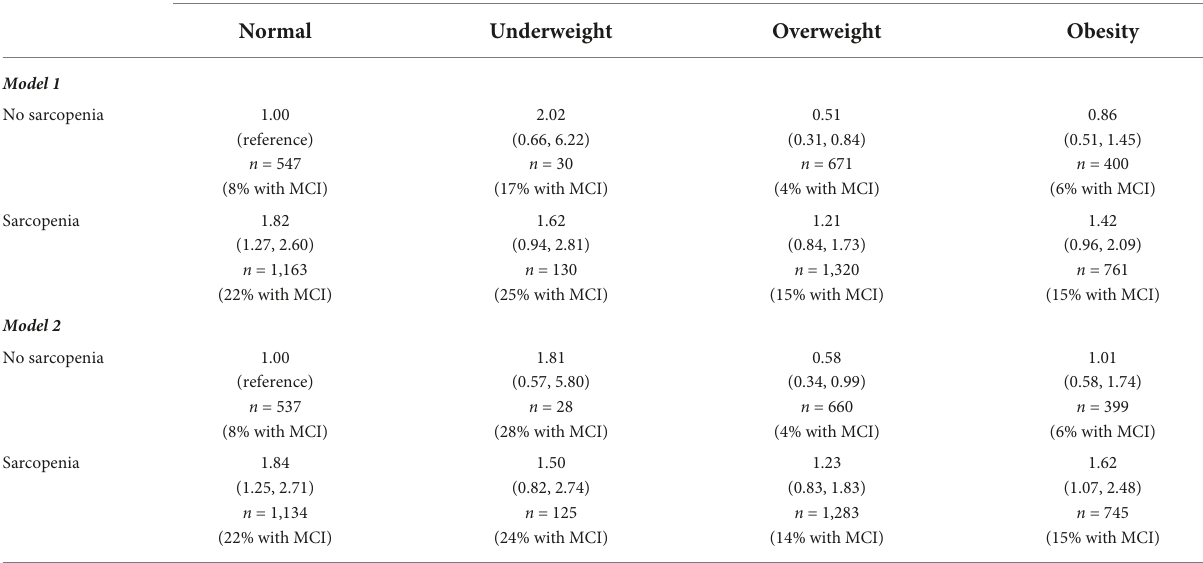
TABLE 4 Combined associations of body mass index and sarcopenia with mild cognitive impairment, where sarcopenia is defined as low grip strength or slow chair stands. Body mass index Normal Underweight Overweight Obesity